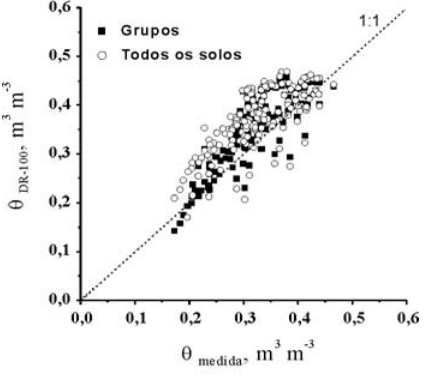
Figura 7. Comparação da umidade estimada pela TDR com as equações de calibração geral (para todos os solos) e por grupo de textura (classes de solos).